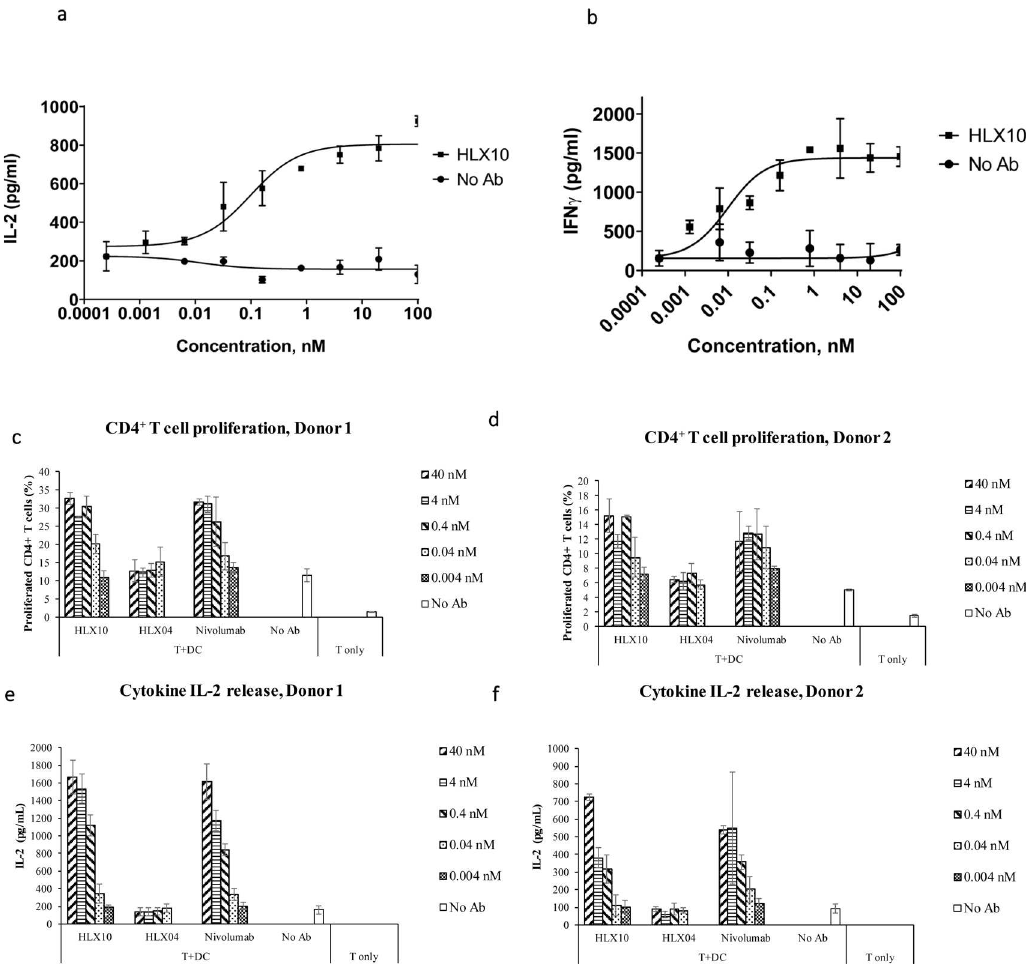
Fig 4. IL-2 and IFN- γ dose–response curve of HLX10 in a mixed DC/CD4+ T-cell MLR assay. (a, b) IL-2 and IFN- γ levels in the supernatants were determined by ELISA after 48 h and 5 days of culture, respectively. Data are presented as increase in cytokine levels relative to untreated cell (no Ab). Each datapoint represents mean ± SD (n = 3). (c, d) Effect of increasing doses of HLX10 and Nivolumab on CD4+ proliferation, as measured by CFSE staining by flow cytometry of two independent donor pairs. Data are presented (horizontal bar) as percent increase in CFSE stained population relative to untreated, no antibody and T-cell only controls. Each bar represents the mean ± SD. Nivolumab and HLX04 (anti-VEGF) were used as the positive control and negative controls, respectively. (e, f) Same MLR samples were assessed for IL-2 secretion by ELISA. Data are presented as increase in IL-2 levels relative to untreated, no antibody and T-cell only controls. Each graph represents a donor pair, and the horizontal bar is the mean ±